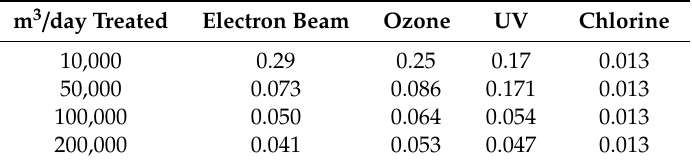
Table 8. Estimated costs comparison for disinfection of sewage water (2010 US $ / m 3